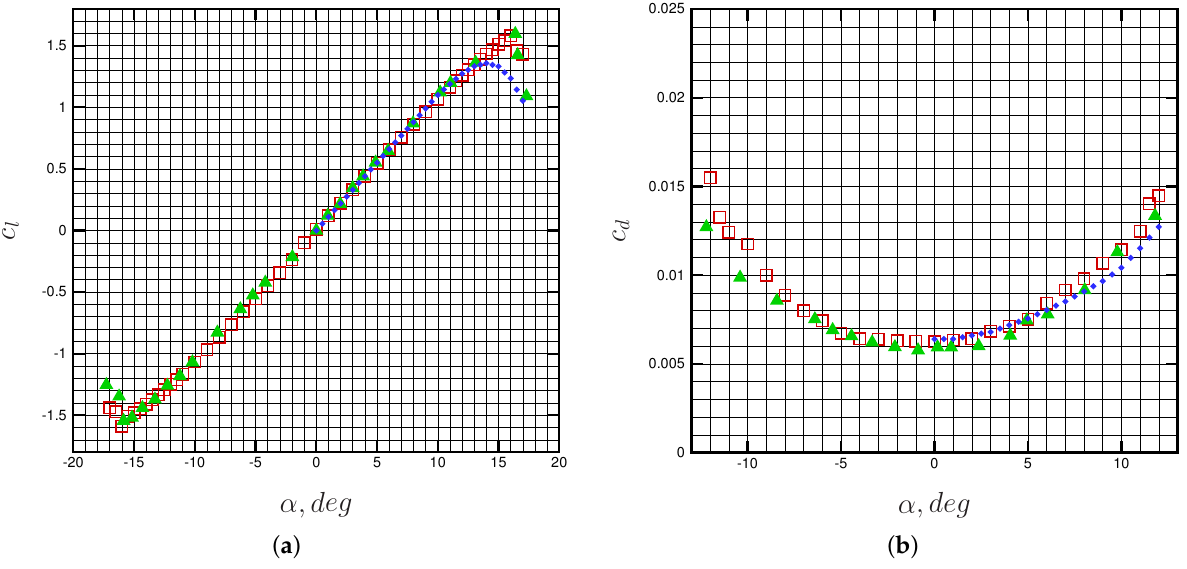
Figure A1. Comparison between CFD and experimental results for the 2-D airfoil: ( a ) c l versus α , and ( b ) c d versus α ; [ ] present study, [ ] ref. [56], and [ ] ref.